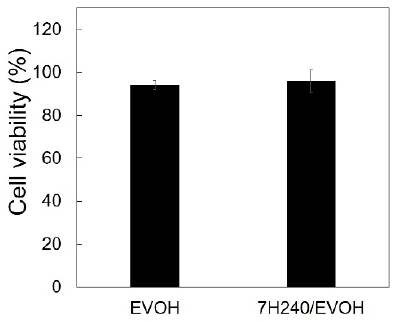
Figure 5. The relative cytotoxicity of the EVOH nanofiber mesh and 7H240 zeolite/EVOH nanofiber mesh in Raw 264.7 cells after incubation at 37 °C for 24 h ( n = 6).